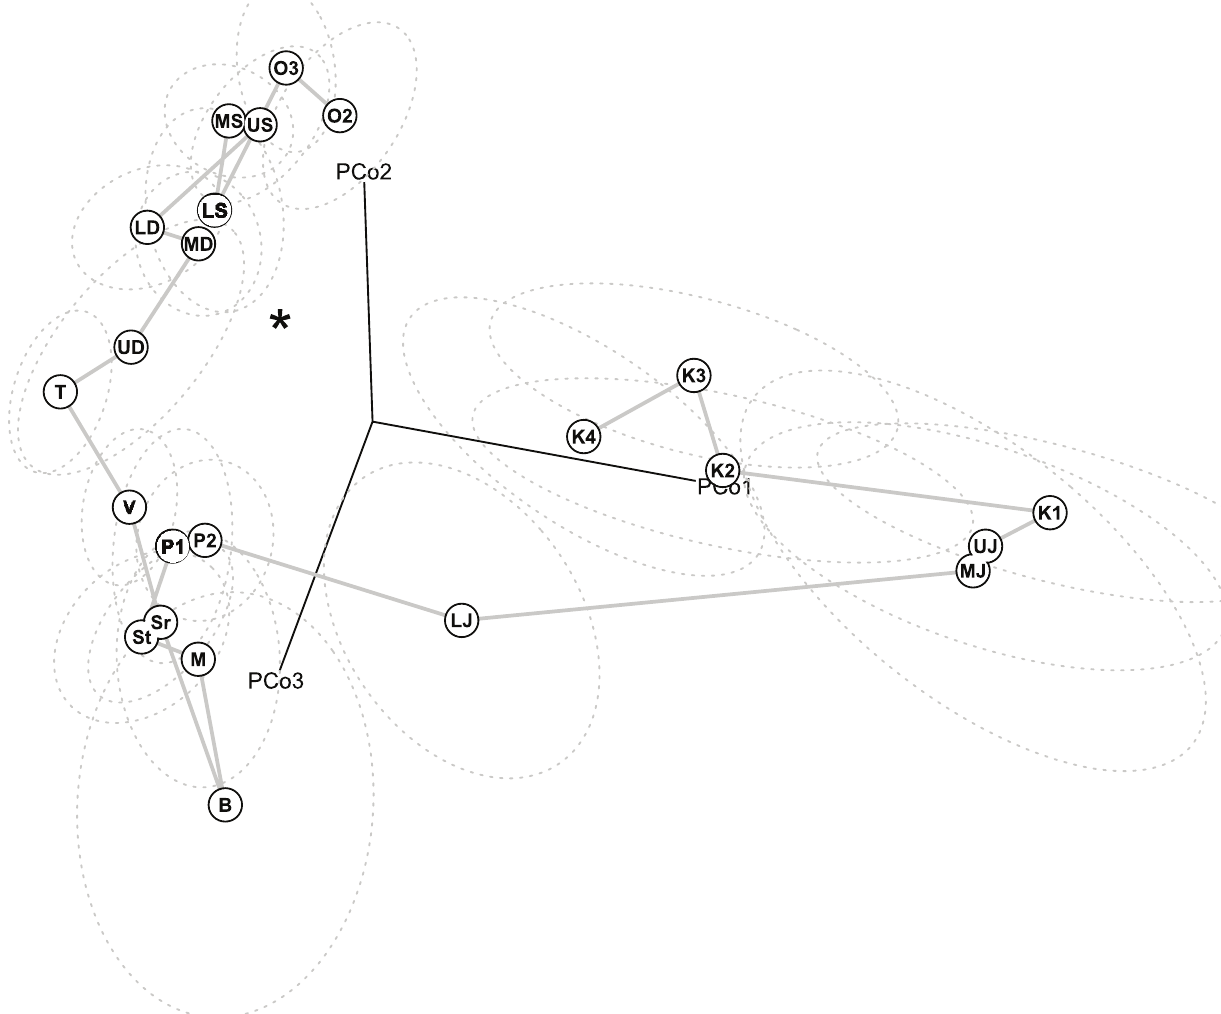
Figure 3. The temporal trajectory of integration patterns of Phanerozoic crinoids. The plot shows the first three principal coordinates of the space of correlation matrices. Each point corresponds to the correlation matrix of crinoids within a given geologic time interval (The correlation between pairwise Euclidean distances in the space of the first three principal coordinates and the actual distances between correlation matrices is 0.85). The grey line represents the temporal trajectory of correlation matrices from the Ordovician (O2) to the end of the Cretaceous (K4), and the asterisk gives the location of the identity matrix (i.e., a matrix with no integration among traits). Dotted lines are 68% confidence ellipses based on bootstrap resampling. Labels: O2=Llanvirnian to lower Caradocian, O3=remainder of Ordovician, LS=Lower Silurian, MS=Middle Silurian, US=Upper Silurian, LD=Lower Devonian, MD=Middle Devonian, UD=Upper Devonian, T=Tournaisian (Carboniferous, Mississippian), Sr=Serpukhovian (Carboniferous, Mississippian), B=Bashkirian (Carboniferous, Pennsylvanian), M=Moscovian (Carboniferous, Pennsylvanian), St=Stephanian (Carboniferous, Pennsylvanian), P1=Asselian-Sakmarian (Permian), P2=Artinskian-Kungurian (Permian), LJ=Lower Jurassic, MJ=Middle Jurassic, UJ=Upper Jurassic, K1=Neocomian (Cretaceous), K2=Barremian-Aptian (Cretaceous), K3=Albian-Turonian (Cretaceous), K4=Senonian (Cretaceous). The first principal coordinate separates Palaeozoic from post-Palaeozoic forms. The distribution of most Palaeozoic correlation matrices near the identity matrix emphasizes their homogeneous structure (roughly similar pairwise correlation among traits), whereas post-Palaeozoic correlation matrices display individuated blocks of correlated traits. crinoids. Similar results are obtained when the space of correlation matrices is built from the set of taxonomically non-significant characters or from a drastic culling of data preserving only characters with less than five percent of missing data.